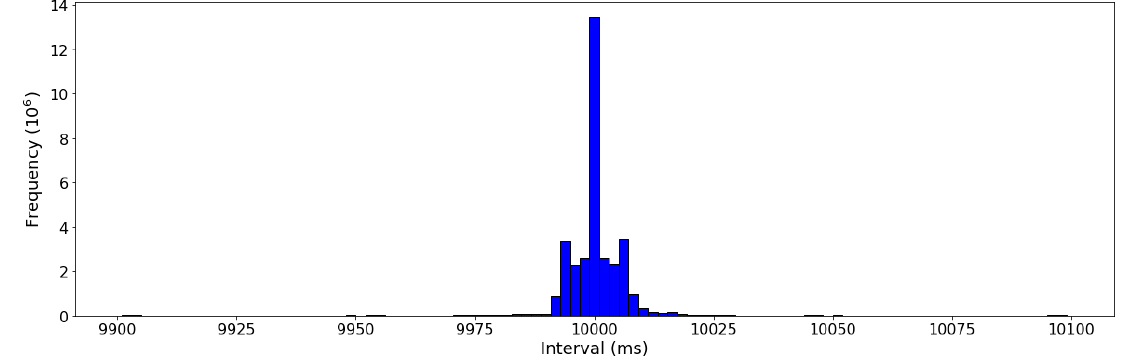
Figure 4. The distribution of the interval between adjacent rows ( [9.9,10.1] ).